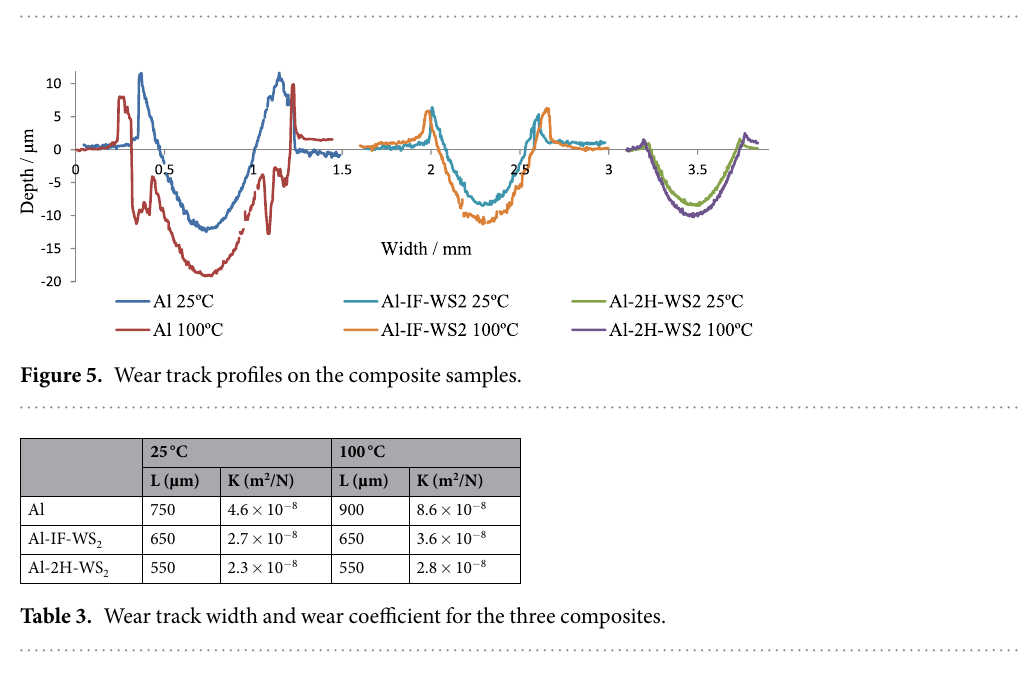
Figure 4. Average friction coefficient of the stroke length during the tests performed at 25 °C ( a ) and 100 °C ( b ).